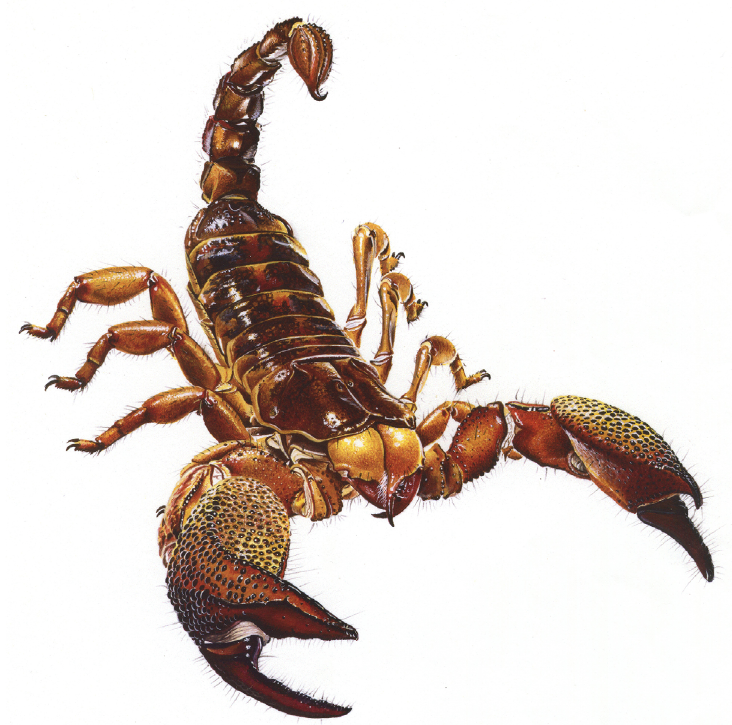
Figure 2. General anatomy of a scorpion. Habitus of Pandinus imperator (C. L. Koch), male from Africa (copyright by B. Duhem, reproduced with